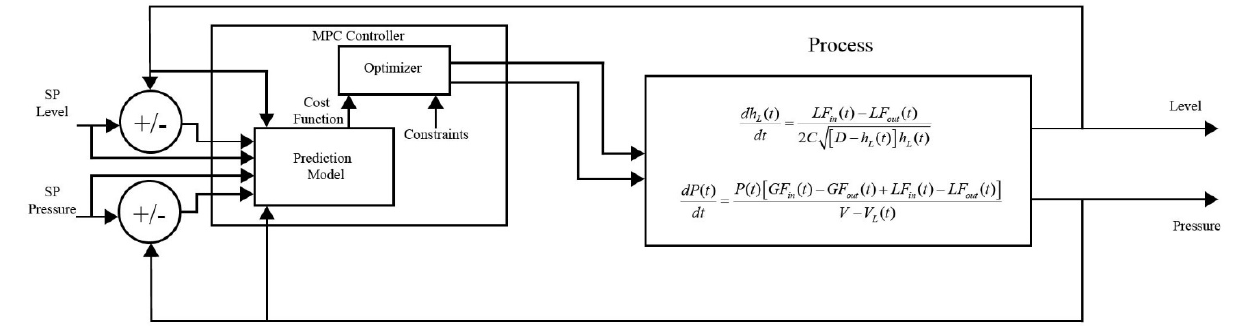
Figure 7. MPC control loop implementation diagram.